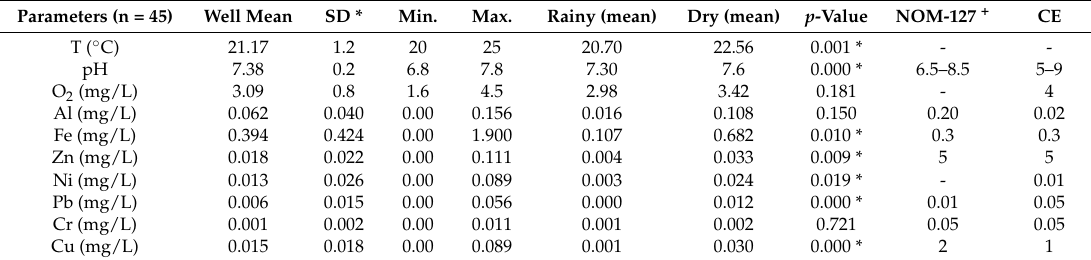
Table 1. Heavy metals in well water. Descriptive statistics, significance value of the Kruskal-Wallis Test for the comparison between rain and drought, and critical values according to two Mexican standards. Well Mean SD * Min. Max.